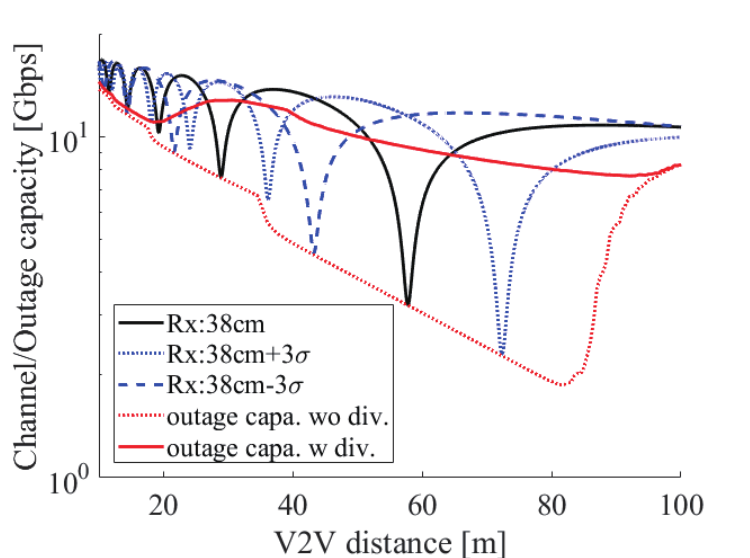
Figure 14. The channel capacity under the two-ray ground reflection model with and without the antenna vibration and the 0.01% outage capacity with and without height diversity at 60